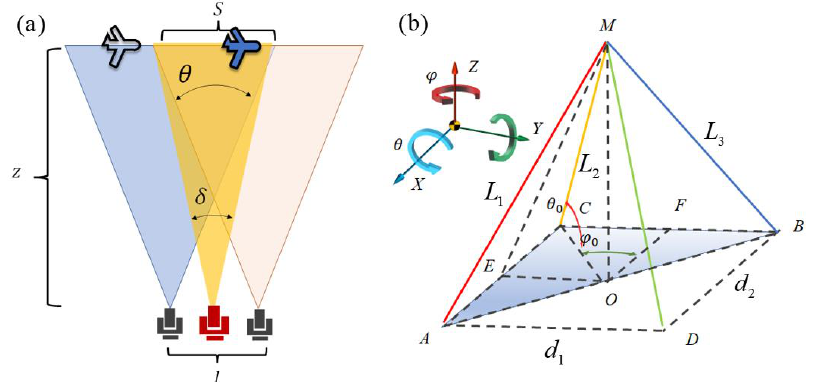
Figure 1. Schematic diagrams of target detection and calculating the position of the target. ( a ) Illus- tration of the target detection. ( b ) Schematic diagram of calculating the spatial position of the target.